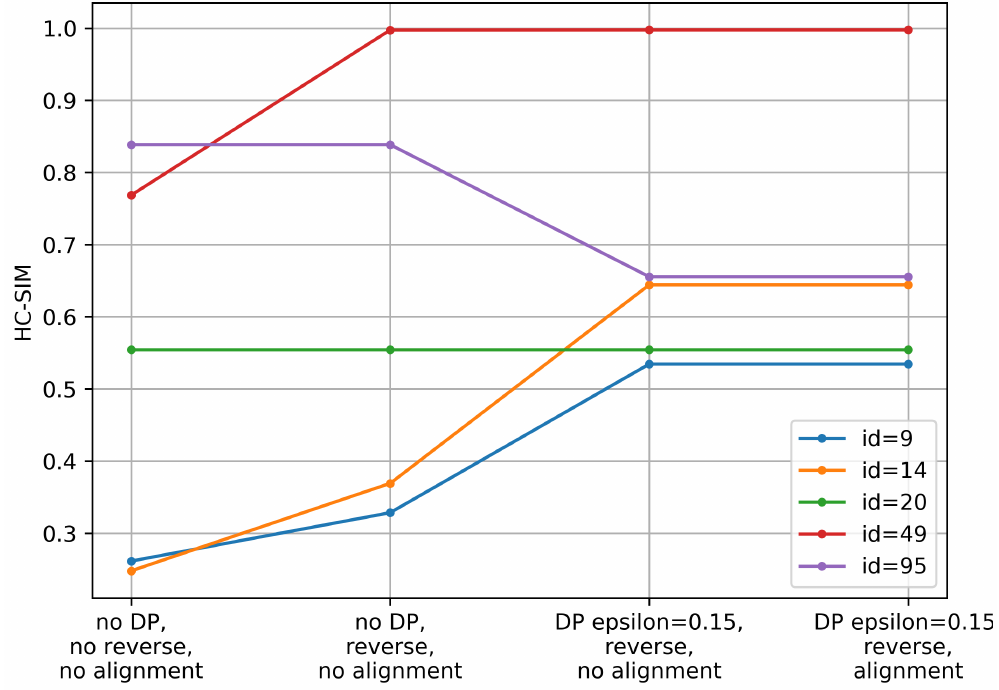
Figure 3. Similarity performance for five single